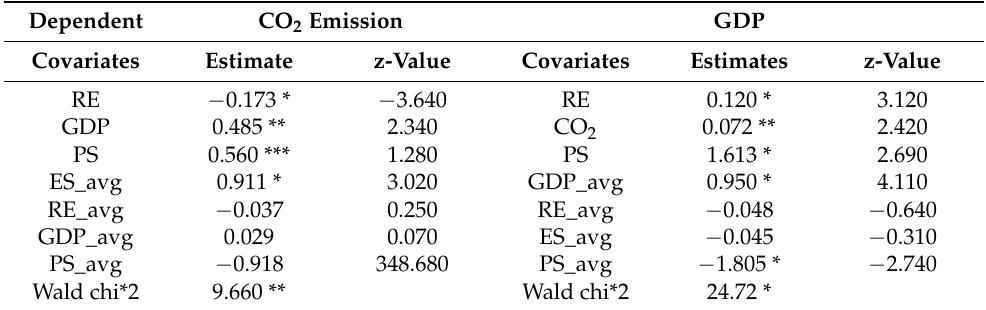
Table 7. Long-run estimates from common correlated effect means group (CCEMG)